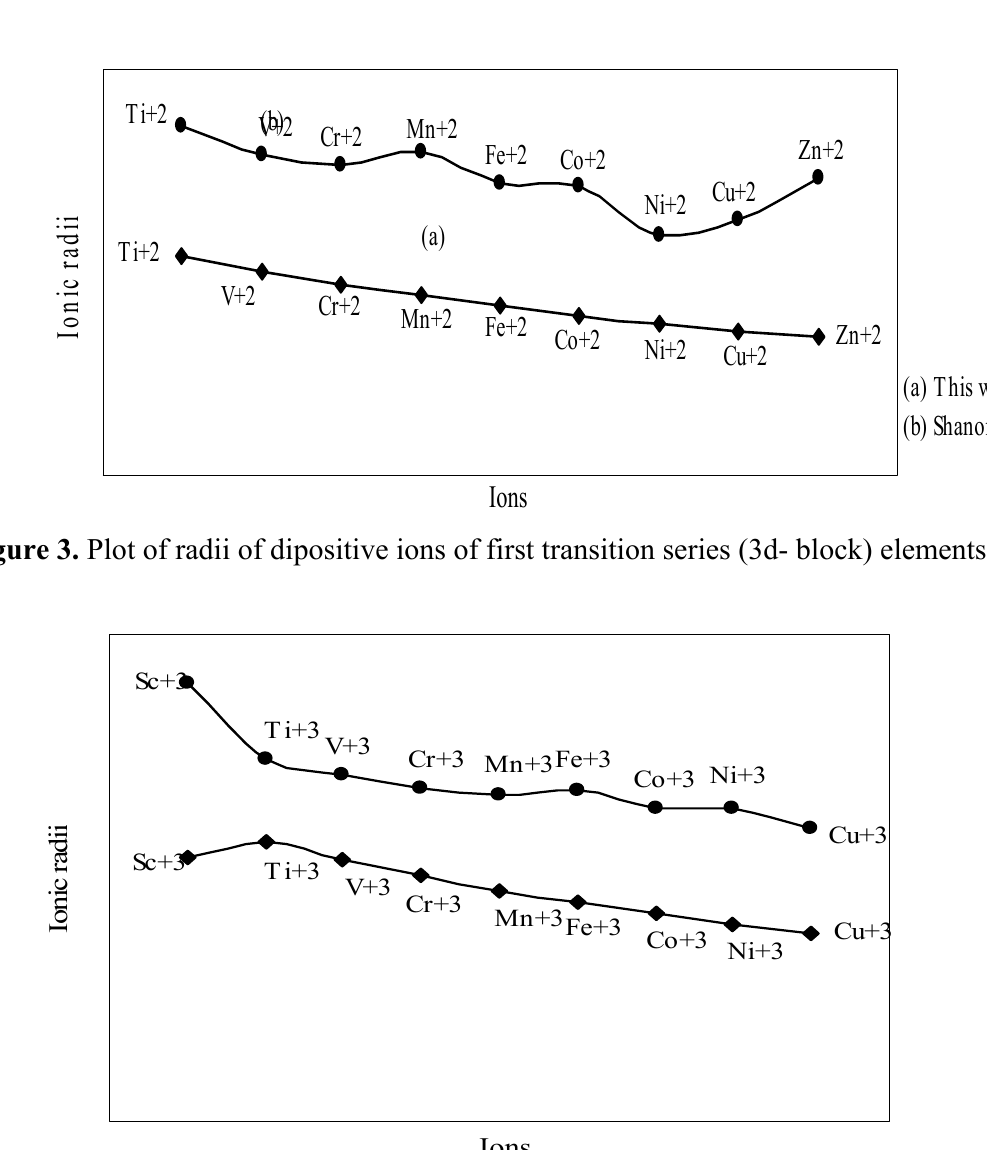
Figure 2. Plot of radii of dipositive ions of Gr-IIA elements